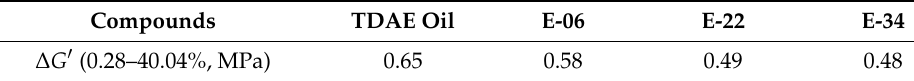
Table 5. Curing characteristics and Mooney viscosities of the compounds.